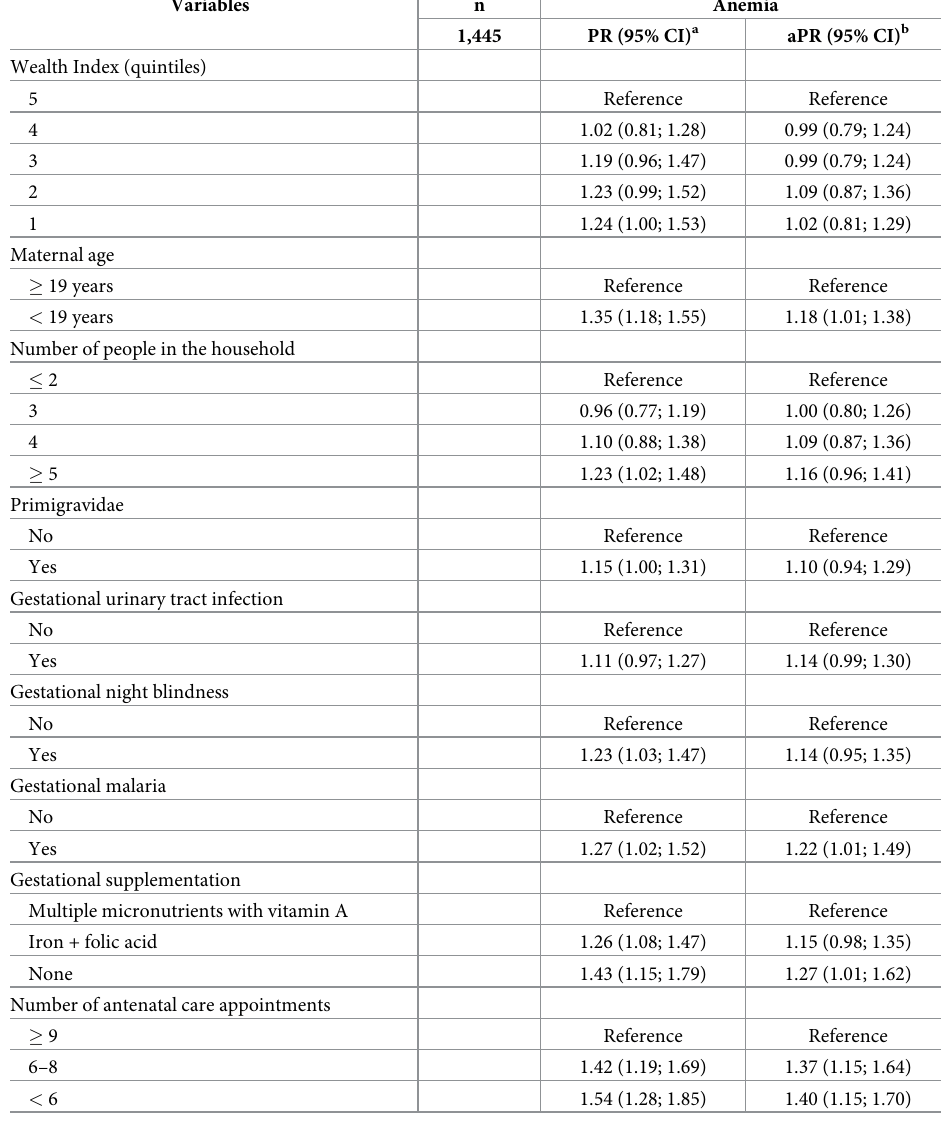
Table 4. Unadjusted and adjusted analysis of associated factors with postpartum maternal